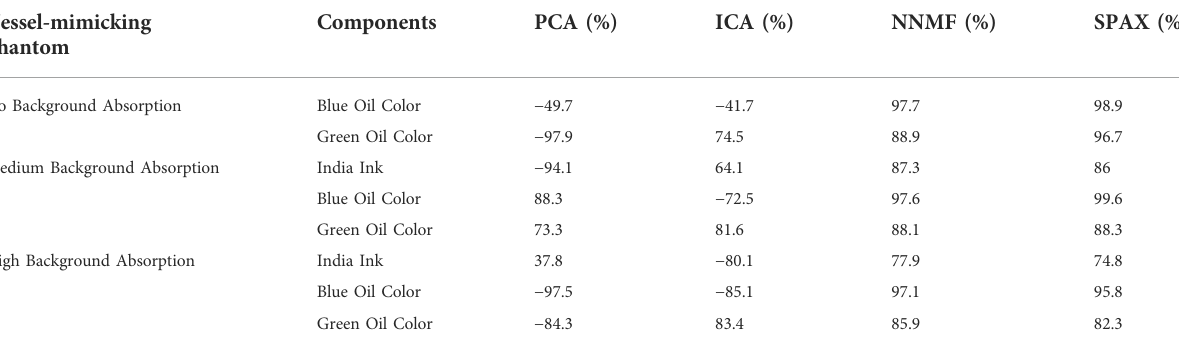
TABLE 2 Correlationvaluesbetween reference spectraobtained via NIRS probeandthe unmixed spectra via BSS algorithms andSPAX frameworkfor the vessel-mimicking phantoms with different background absorption. Vessel-mimicking phantom